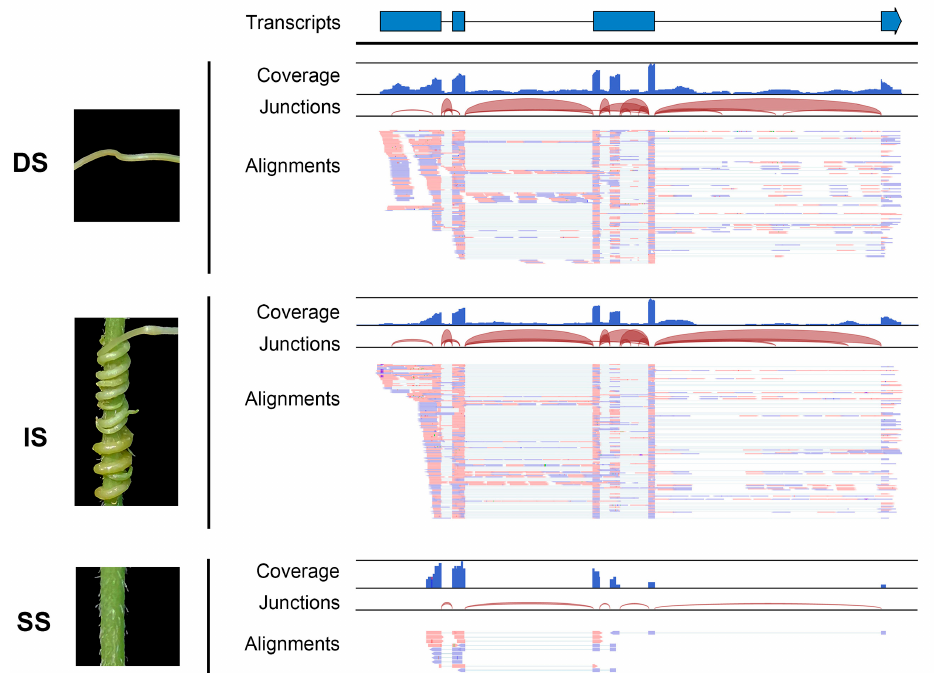
Figure 4. Visualization of read assemblies of the dodder lncRNA MSTRG.10219.19 in three tissues. The lncRNA model at the top indicates exons as blue bars and introns as line bridges. Each panel includes tracks for total coverage, junction coverage, and read alignments. Reads that span junctions are connected with thin lines. DS, IS, and SS represent dodder stems, interface stems, and soybean stems, respectively.